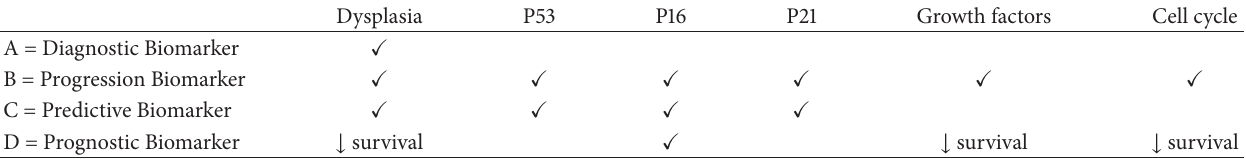
Table 2: Synopsis of biomarkers in the GERD-BE-EAC axis. According to Table 1, most promising biomarkers are summarized indicating that only dysplasia is involved in all four categories. Dysplasia can be used as diagnostic biomarker as well as to assess the risk of progression to EAC or response to therapy and is associated with poor survival ( ↓